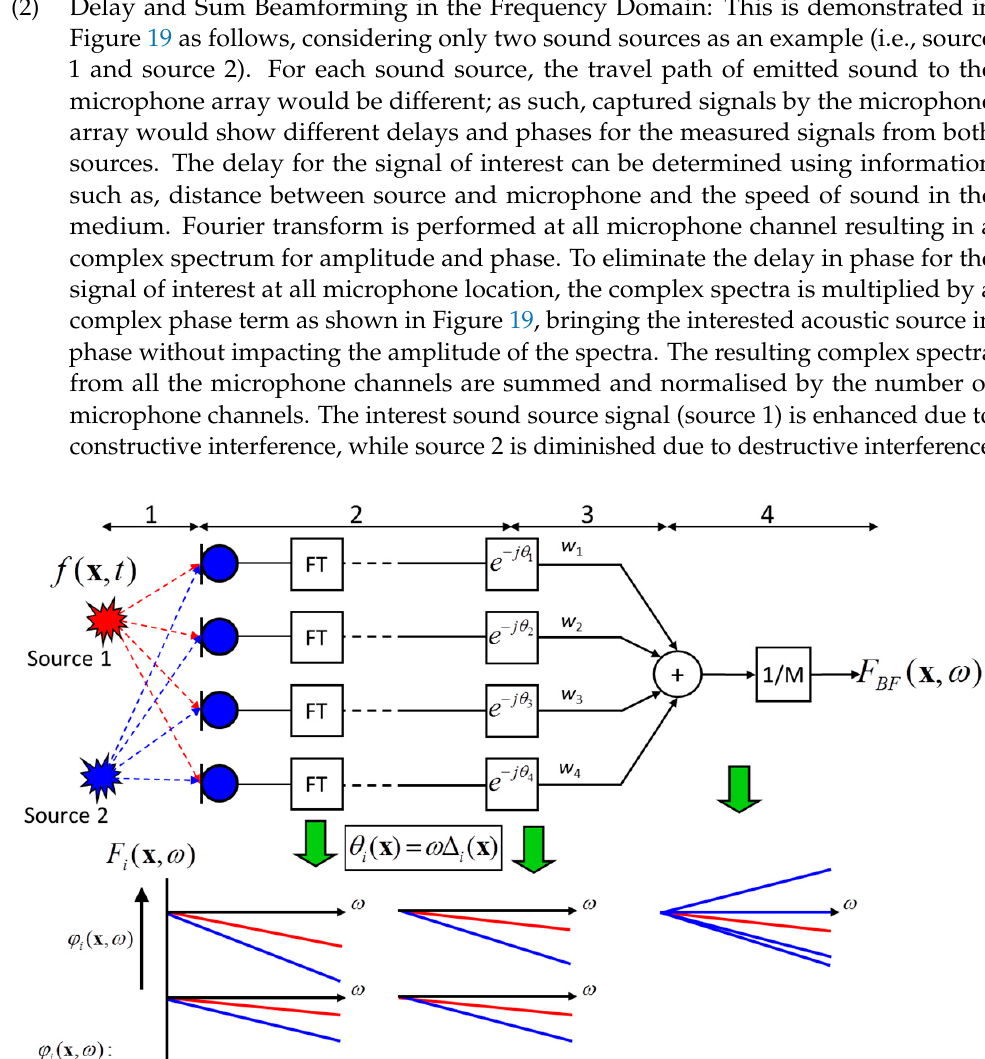
71 Figure 18. Schematic of delay and sum beamforming in the time domain for acoustic sources [83].